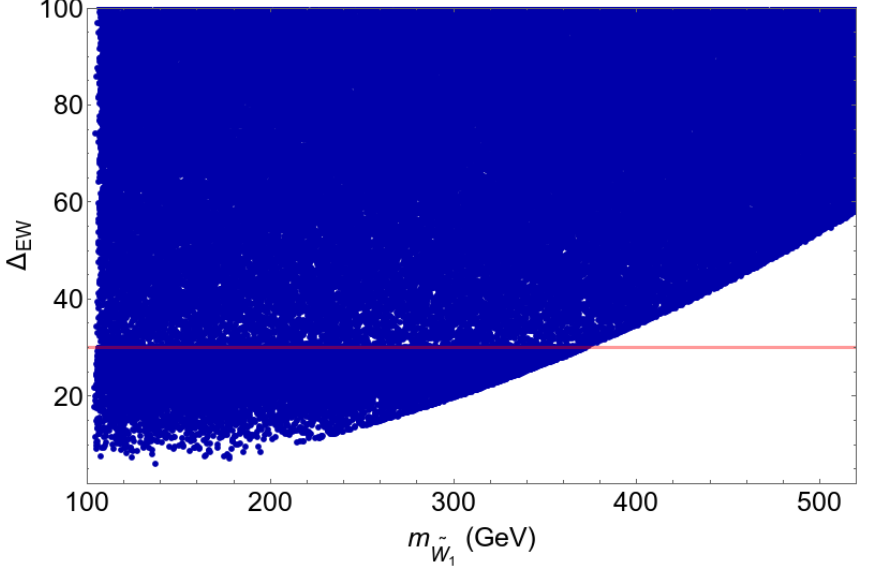
Figure 16 . Plot of (cid:1) EW vs. m from a scan over natural mini-landscape parameter space with f W 1 m 0 (1 ; 2) ’ m 3 = 2